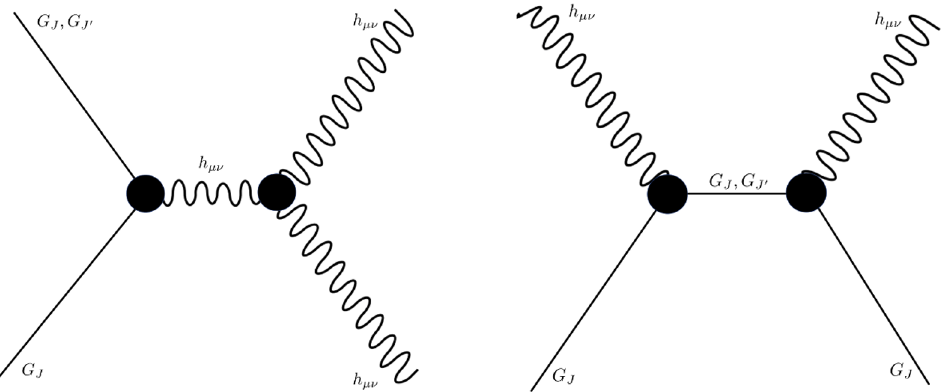
Figure 3 . The process at left constrains the G J G J 0 h vertex, requiring it to be suppressed by a power of the scale Λ where new HS particles contribute to the process. The process at right gr involves the exchange of a J ≥ 3 HS particle G . The contributions from other HS particles G J the diagram at right are suppressed compared to G due to the constraints on the diagram at J